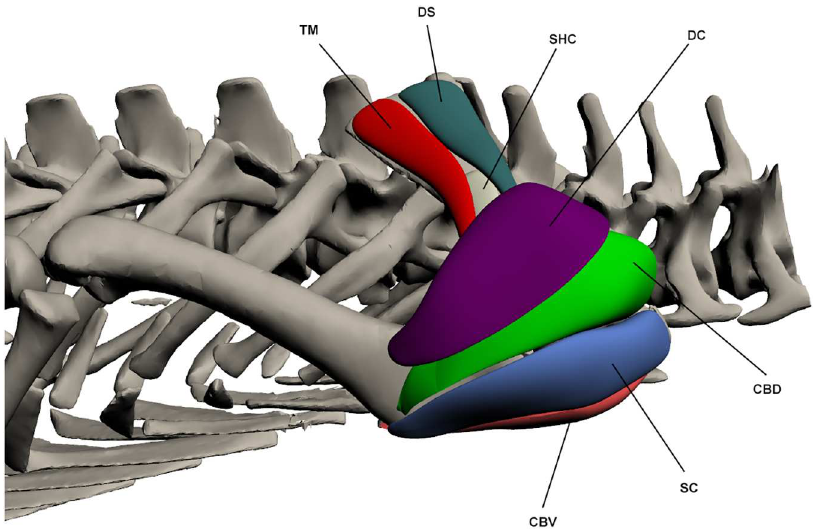
Fig 8. Intrinsic muscles of the forelimb: shoulder extensors and flexors. TM: Teres major , DS: Deltoideus scapularis , SHC: Scapulohumeralis caudalis ,DC: Deltoideus clavicularis , CBV: Coracobrachialis brevis ventralis ,SC: Supracoracoideus , CBD: Coracobrachialis brevis dorsalis